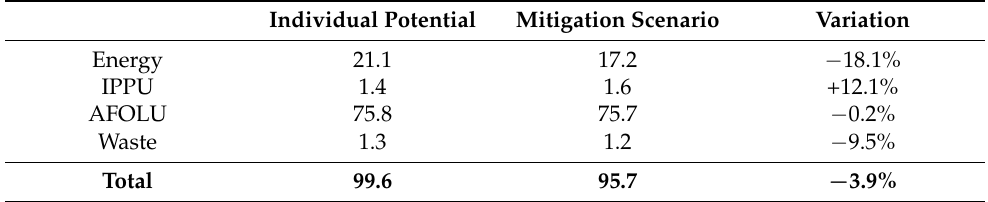
Table 14. Mitigation potential of mitigation actions by IPCC category, comparing individual (stan- dalone) and combined potential in mitigation action in MtCO 2eq